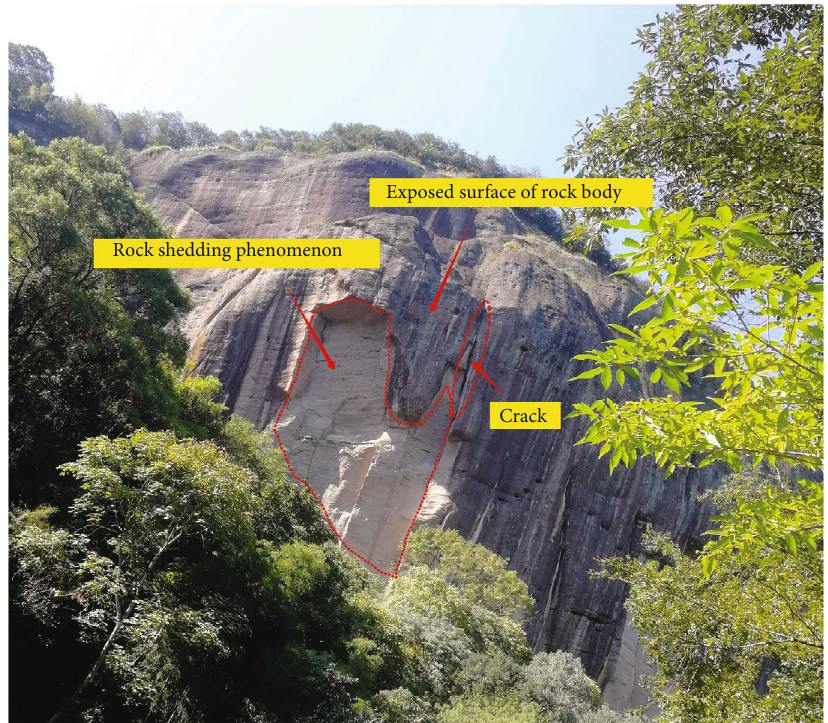
Figure 1: Rock mass landscape at a particular location in the Wuyishan scenic